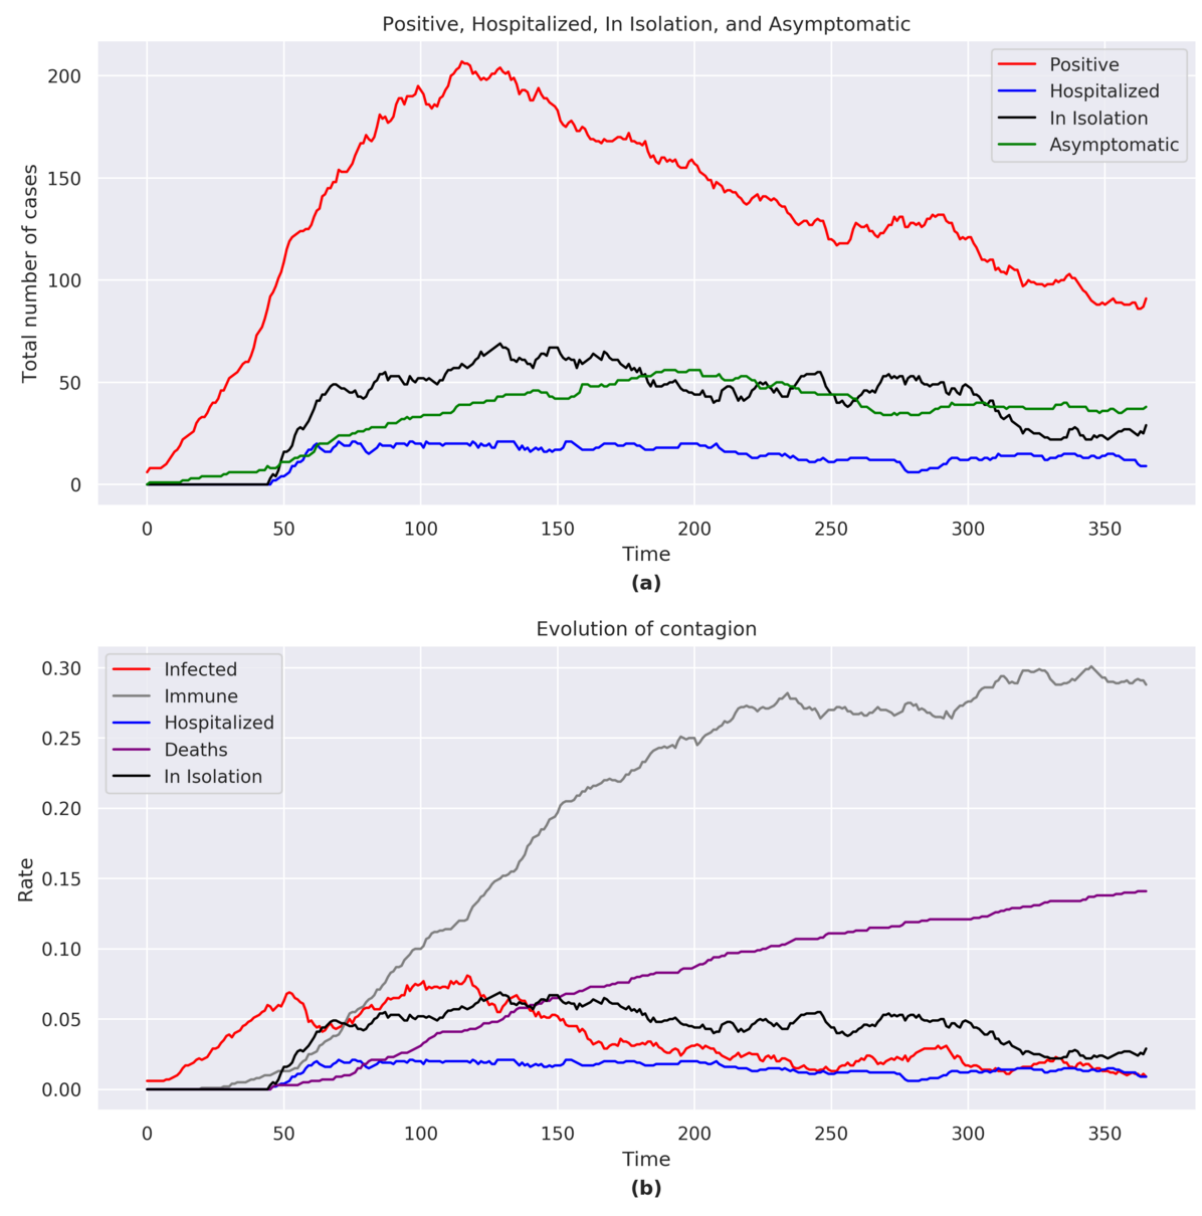
Figure 5. (a) Positive, hospitalized, in isolation, and asymptomatic figures for Sweden. (b) Evolution of the contagion for Sweden. The graphs consider the sum of the agents belonging to each category shown in the legend for each day of the